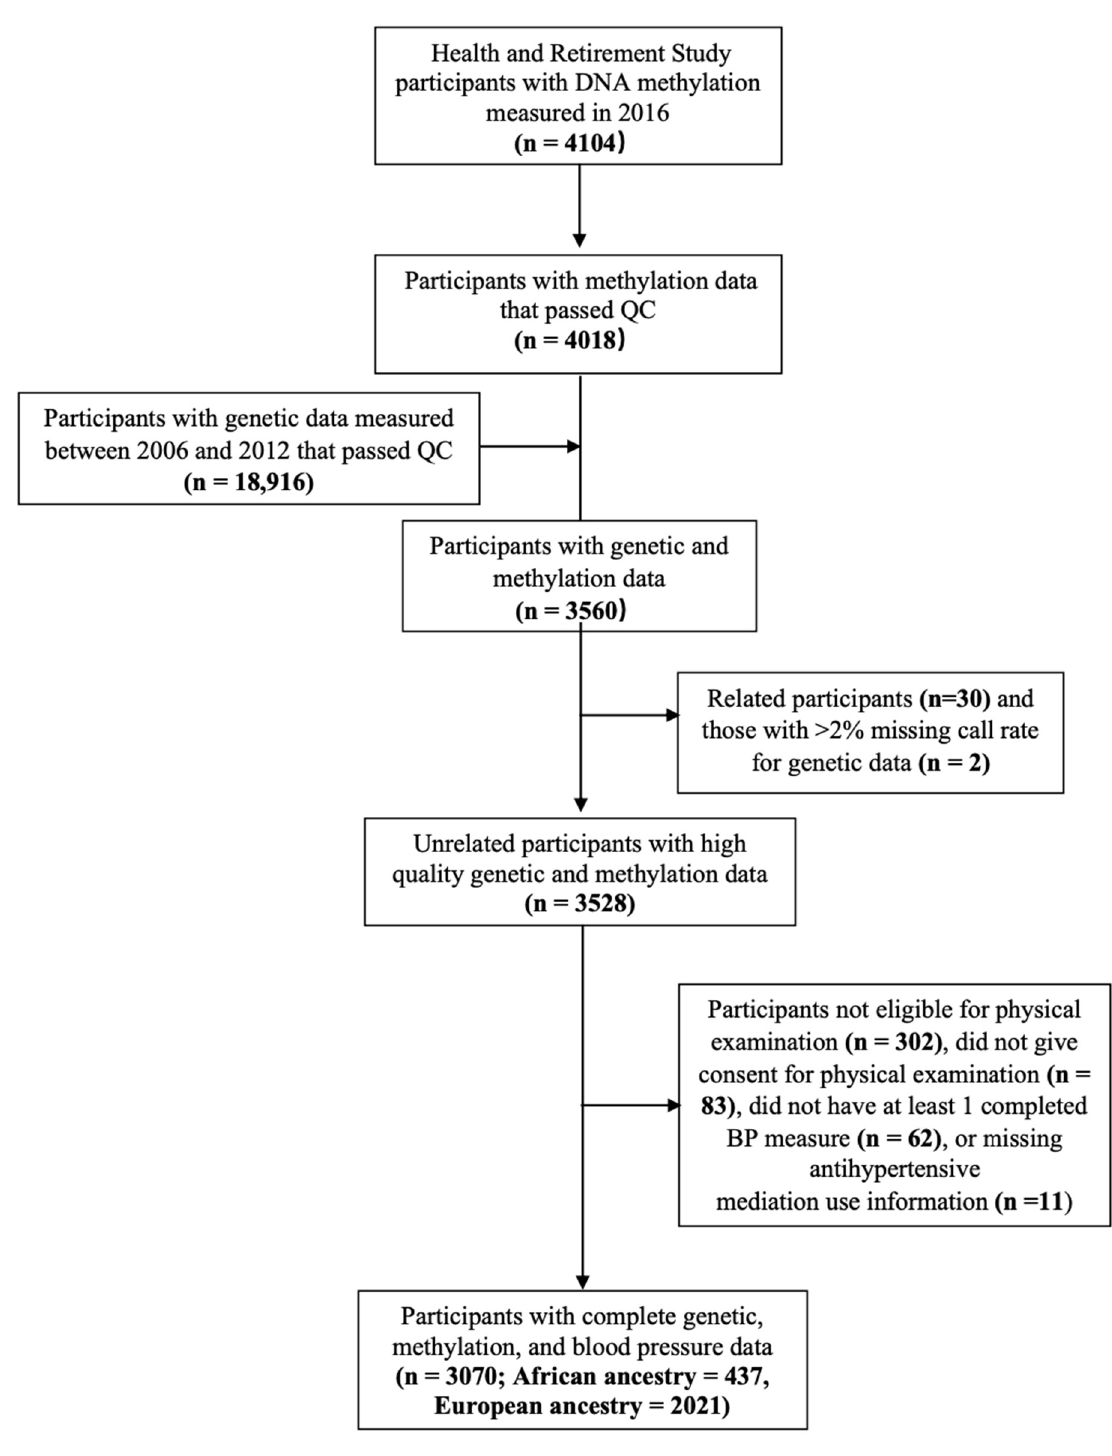
Figure 1. Study selection criteria for the Health and Retirement Study participants.